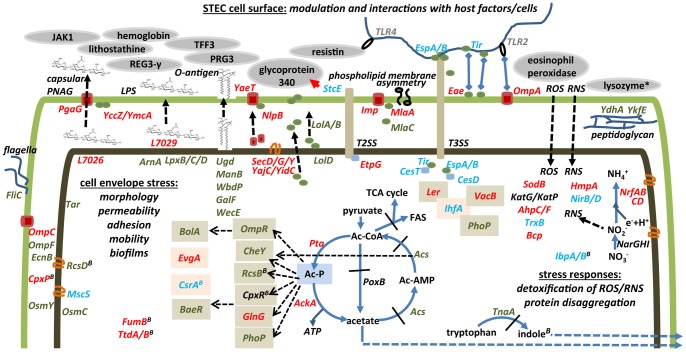
Changes in the EHEC cell envelope during effacement of the host environment and molecular responses initiated by the piglet host.
At the top of the schematic, generally from left to right: Sus scrofa proteins identified as adhesion factors to the bacterial surface; proteins implicated in capsular poly-N-acetylglucosamine (PNAG) and lipopolysaccharide (LPS) biosynthesis; proteins implicated in β-barrel OM protein synthesis (YaeT and NlpB), lipoprotein export (LolA, LolB and LolD), OM asymmetry (Imp, MlaA and MlaC); T2SS and T3SS effectors and some of the established interactions with host cells and the extracellular matrix (StcE, EspA/B, Eae/Tir and OmpA); putative peptidoglycan-modulating proteins (YdhA and YkfE). Below from left to right: various extracytoplasmic stress responses; regulators of cell envelope stress and the connection to acetyl phosphate (Ac-P) signaling; tryptophan/indole biosynthesis; ROS and NOS mediated stress responses by peroxidases, catalases, dismutases and NO-detoxifying enzymes.